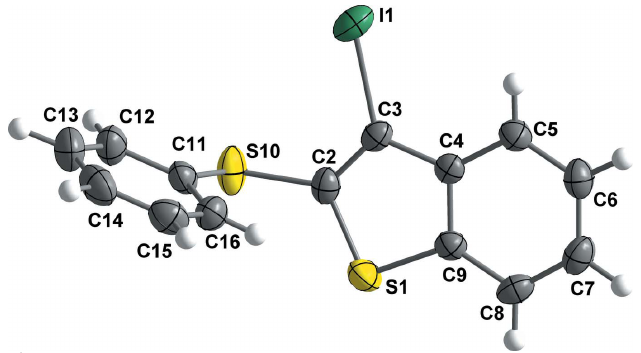
Figure 2 The molecular structure of 3-iodo-2-(phenylsulfanyl)benzo[ b ]thiophene ( 2 ), with displacement ellipsoids drawn at the 50% probability level.